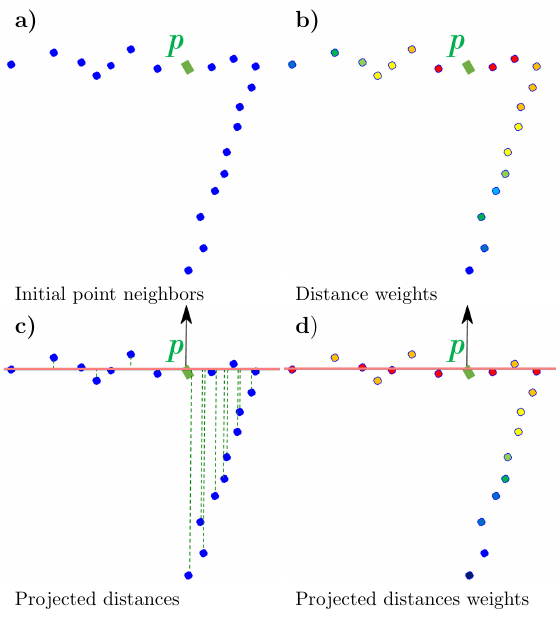
Figure 2. Weighted forms of filtering in b, d) blue = small weights, red = large